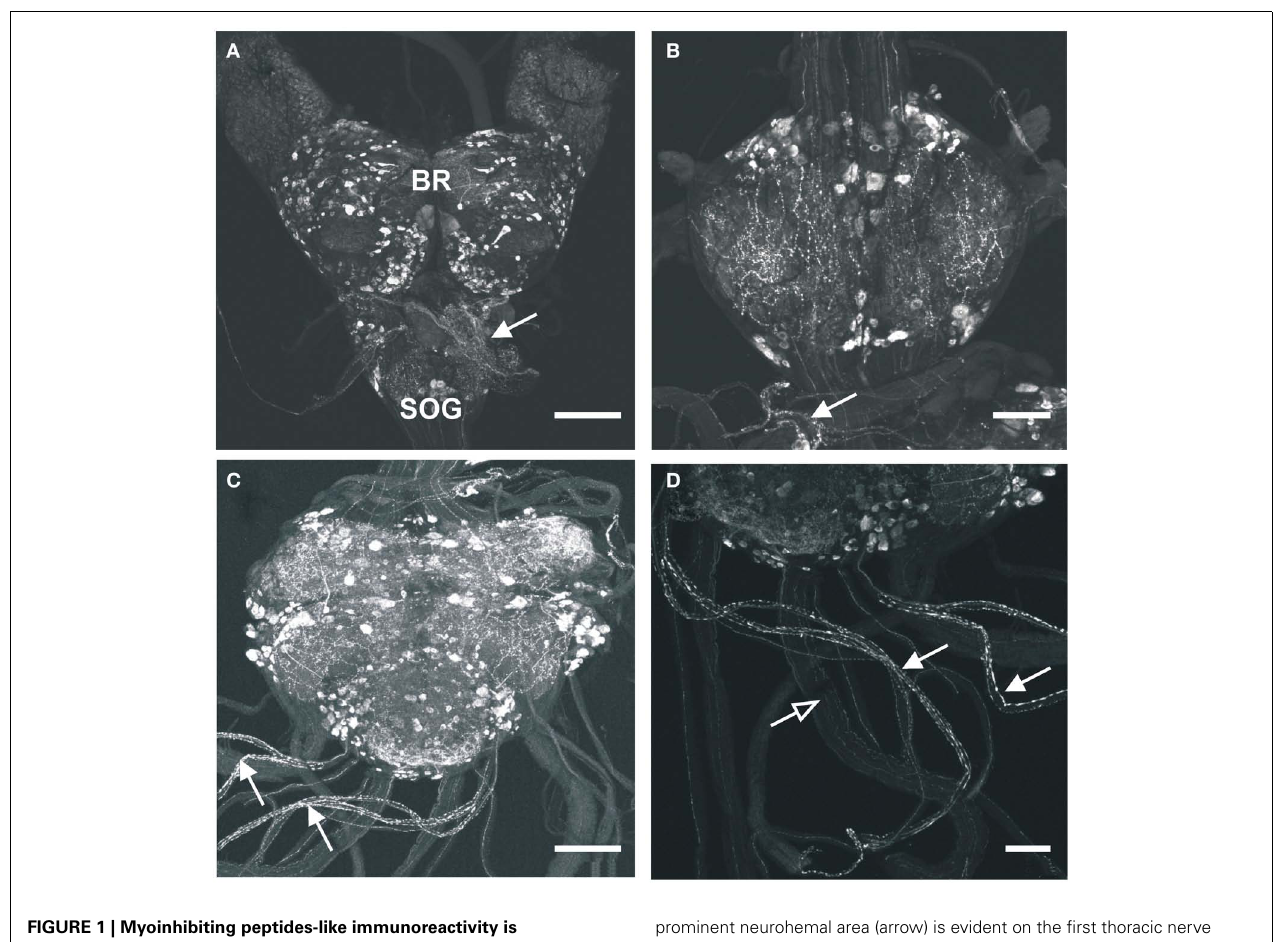
FIGURE 1 | Myoinhibiting peptides-like immunoreactivity is associated with cells and processes within the central nervous system of R. prolixus . (A) MIP-like immunoreactivity in cells and processes of the brain (BR) and sub-esophageal ganglion (SOG). Immunoreactive processes are also seen on the corpus cardiacum and corpus allatum (arrow). (B) MIP-like immunoreactive cells within the prothoracic ganglion as well as processes within the connectives.